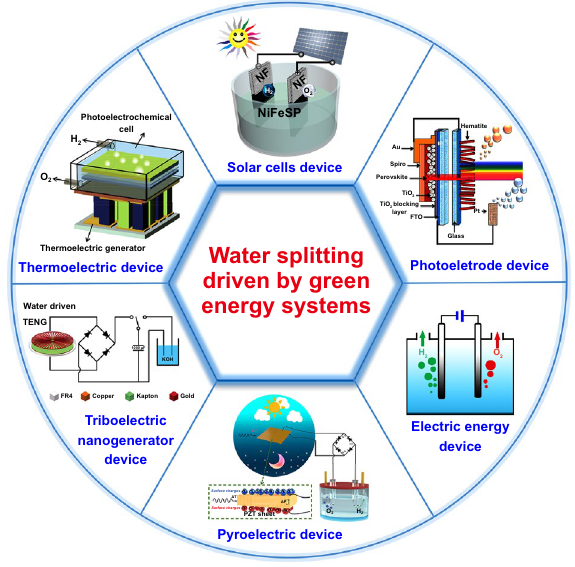
Fig. 1 Water splitting driven by different green energy